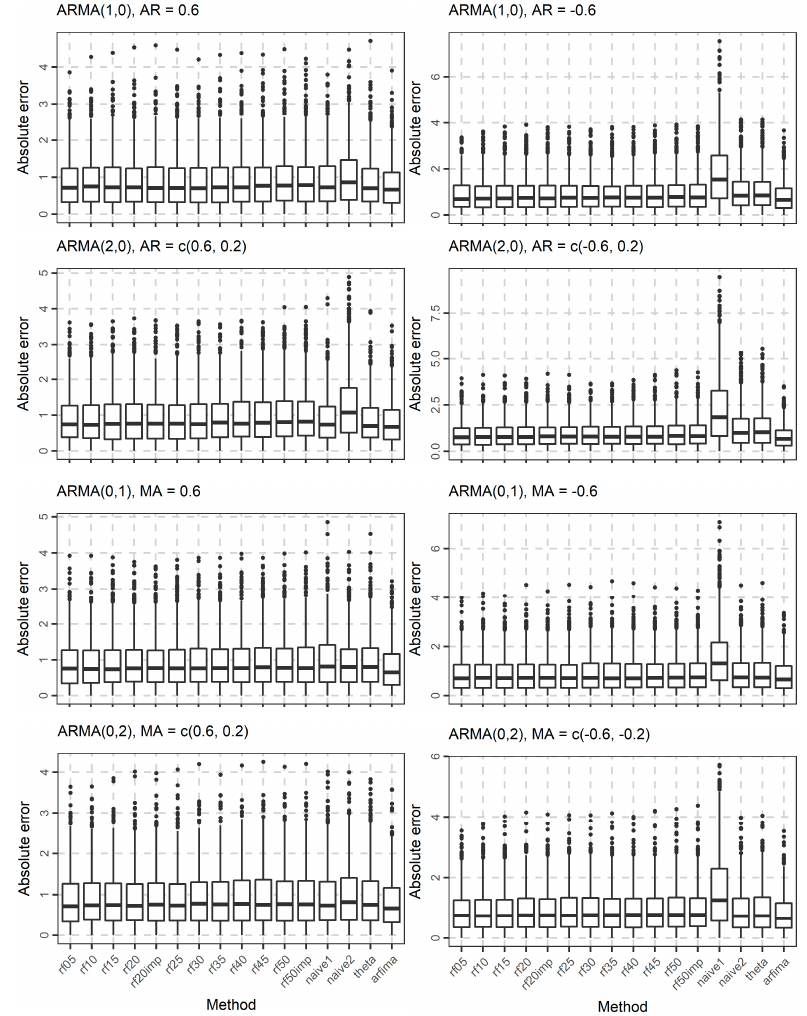
Figure 4. Boxplots of the absolute errors when forecasting the 101st value of 1000 simulated time series from each ARMA( p , 0) and ARMA(0, q ) model used in the present study.